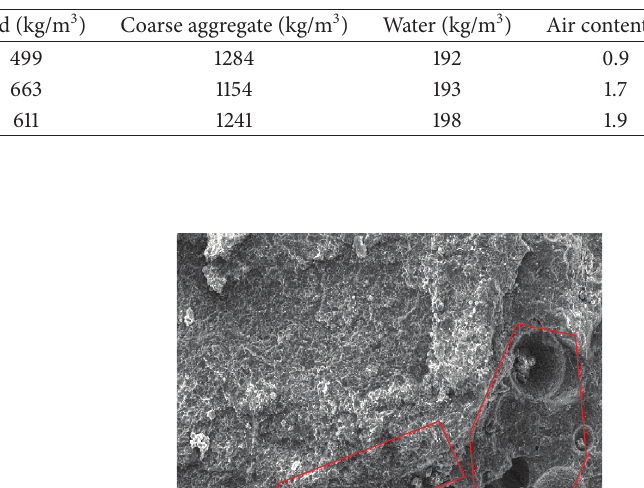
Table 1: The mix proportion of plain concrete per cubic metre.